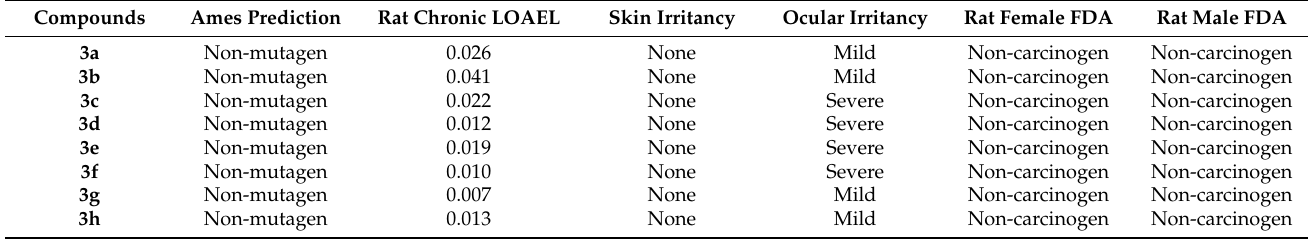
Table 2. In silico TOPKAT evaluation of the series of synthesized 1-aryltetrahydroisoquinoline